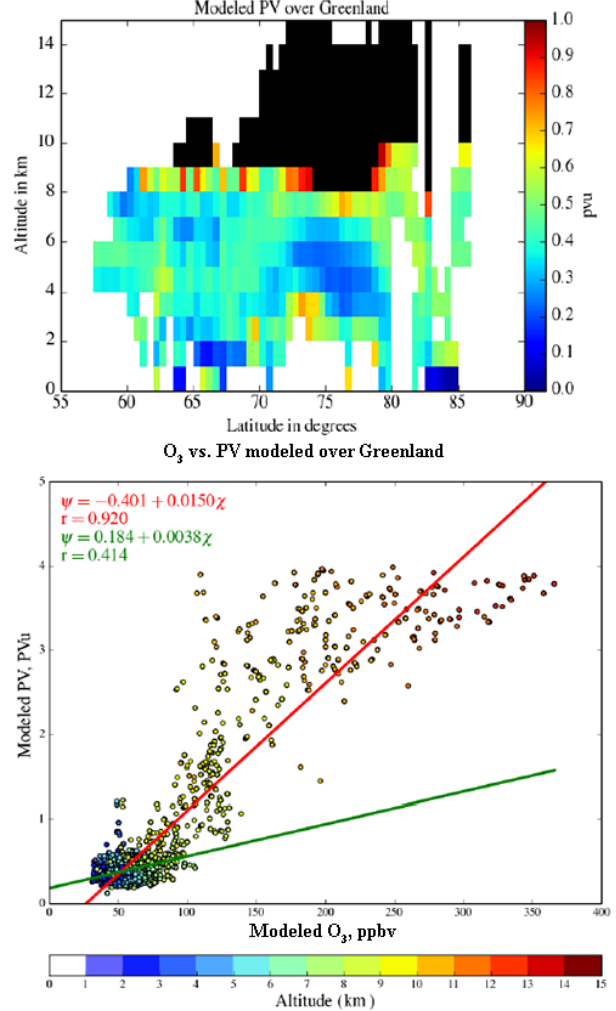
Figure 10. Same as Fig. 8 but for the Greenland